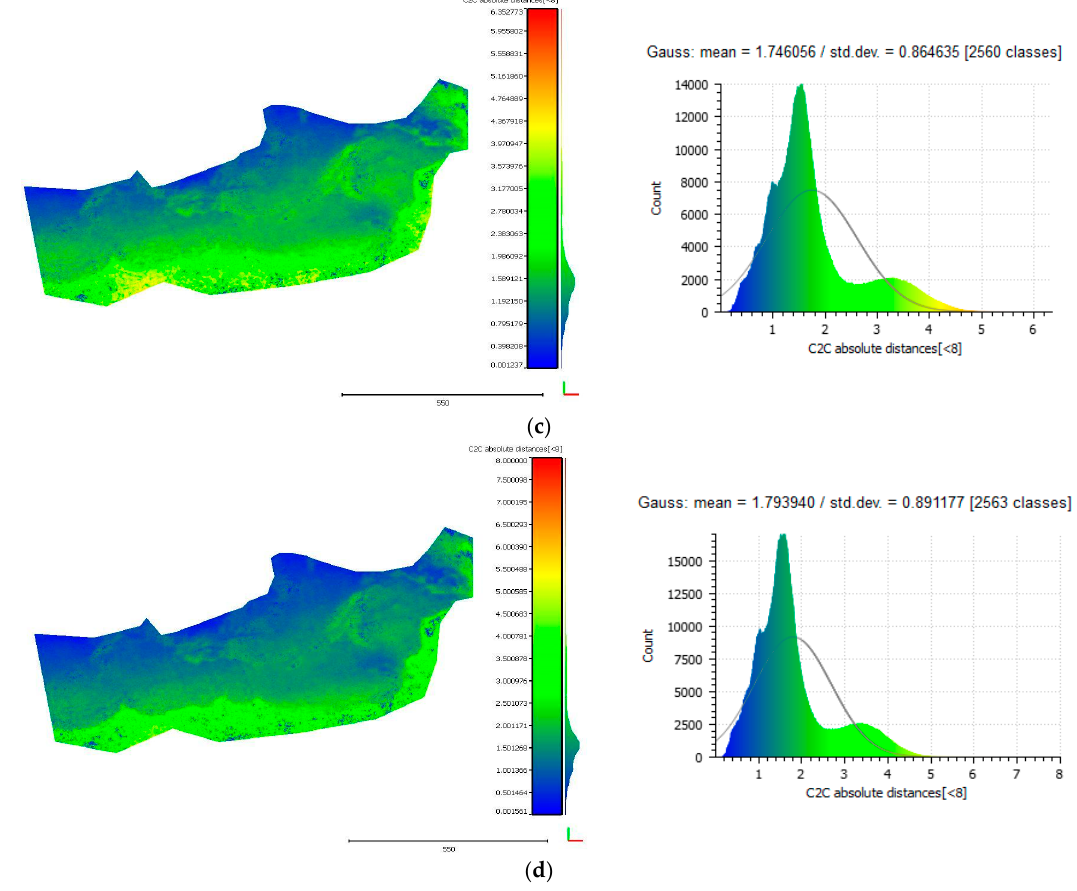
Figure 17. The cloud-to-cloud distances between the initial point cloud and the point clouds that resulted from each iteration of the algorithm on the Agia Napa test site. Row ( a ) presents the cloud-to-cloud distances between the initial point cloud and the point cloud that resulted from the first iteration of the algorithm and their respective histogram. Rows ( b – d ) present the cloud-to-cloud distances between the initial point cloud and the point cloud that resulted from the second, third and fourth iteration of the algorithm respectively.